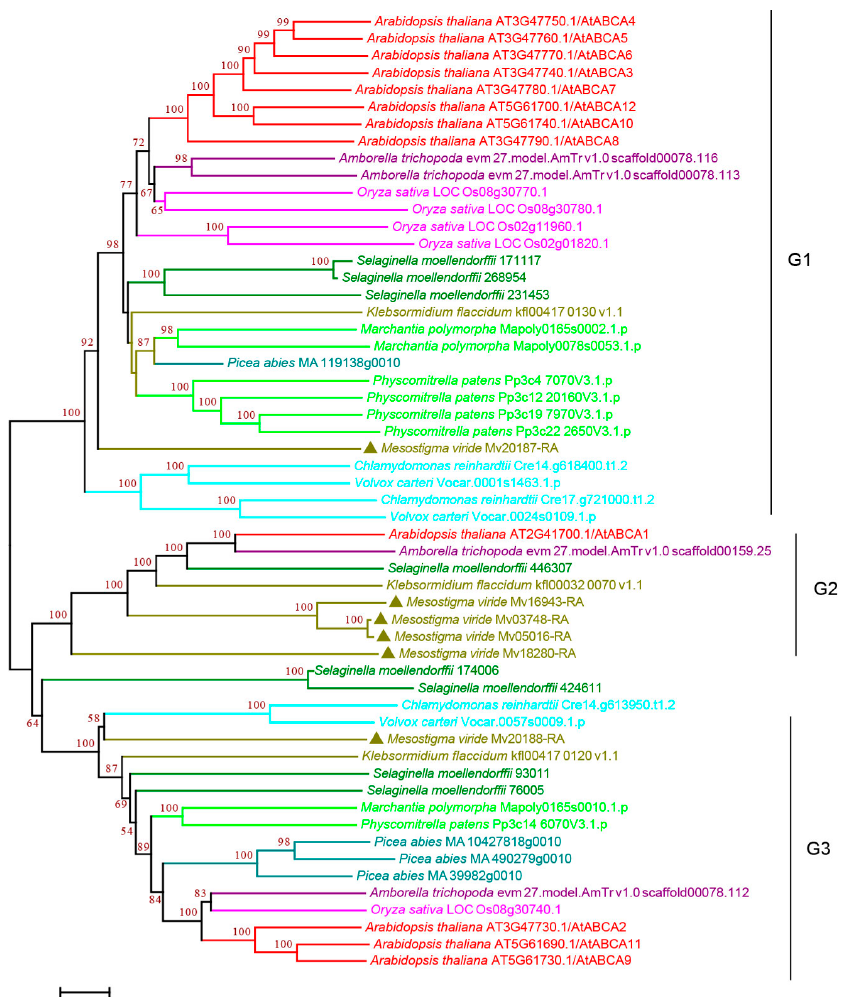
Figure 2. Phylogenetic analysis of ABCA subfamily proteins from 11 evolutionarily representative plant species. A neighbor-joining (NJ) tree was generated using MEGA7 with 1000 bootstrap repli- cates, and bootstrap values >50% are shown on the branches. The M. viride proteins are highlighted by